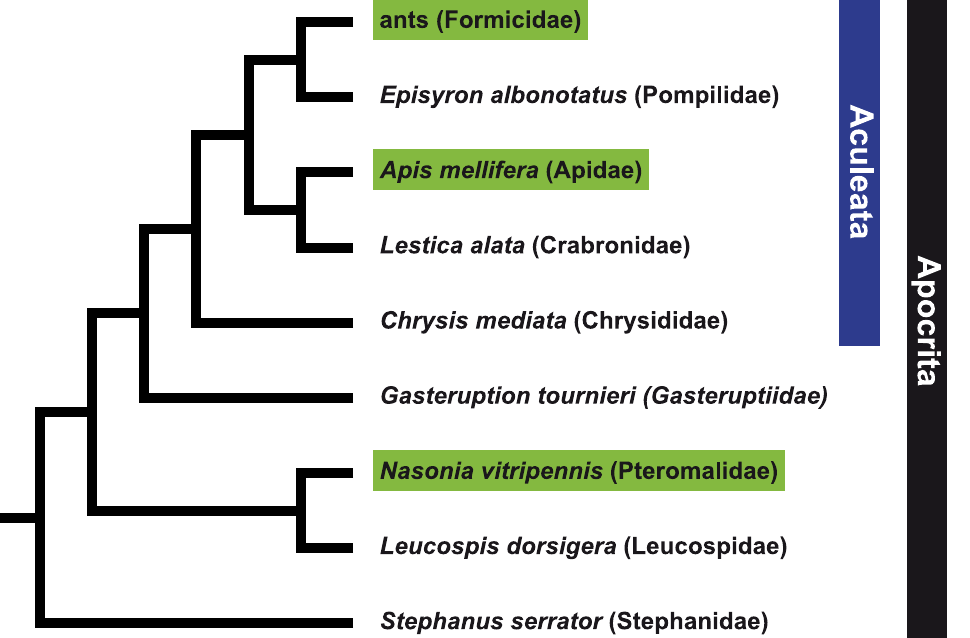
Figure 1. Hypothesized phylogenetic relationships of apocritan Hymenoptera studied in this investigation [ 4,12 ] . Taxa with sequenced genomes are highlighted in green; their genome sequences were analyzed to identify single-copy genes and to design degenerate oligonucleotide PCR primers. DNA of non-highlighted species was used to assess the functionality of the inferred PCR and sequencing primers. doi:10.1371/journal.pone.0039826.g001 between 2 and 12,288 (avg. 860) (Table S1). The expected sizes of